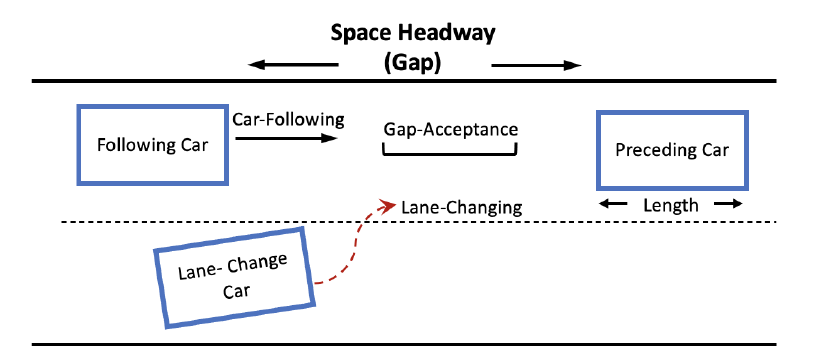
Figure 4. Illustration for the car-following, lane-change, and gap-acceptance